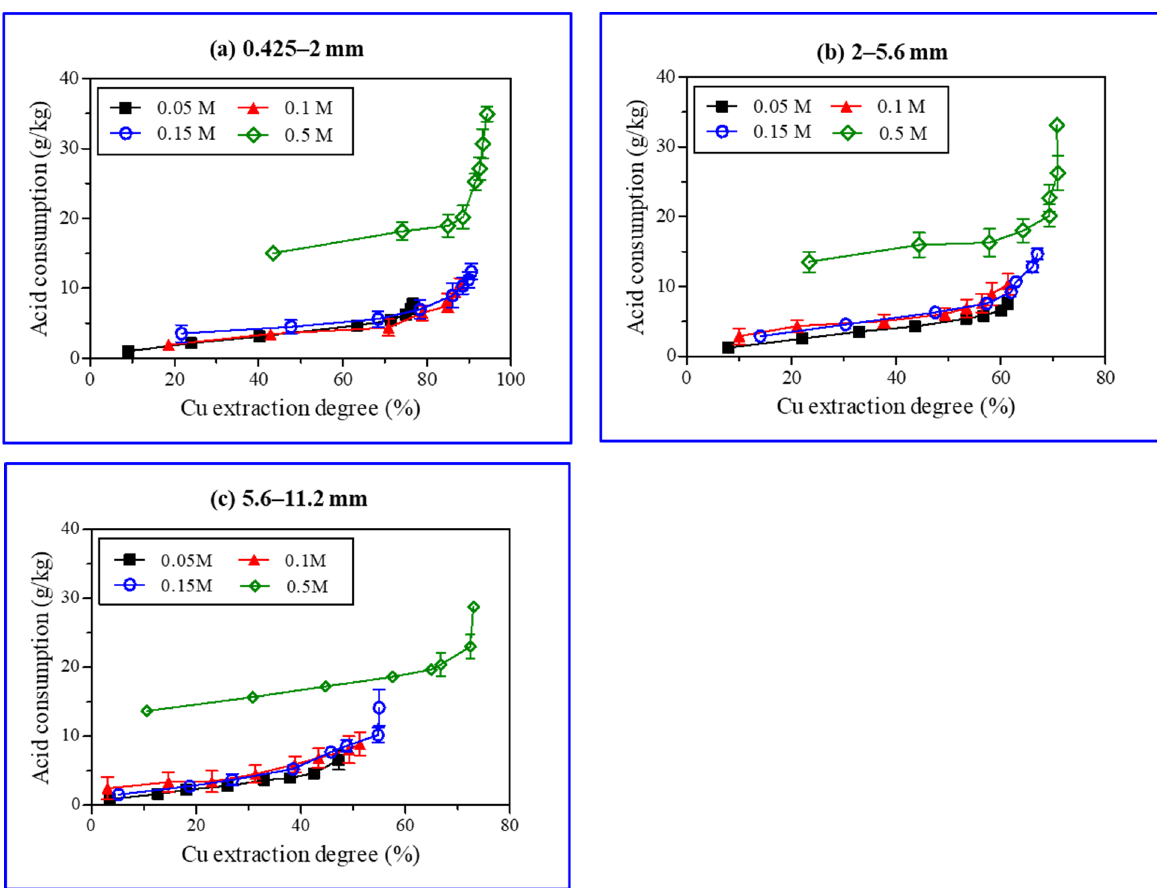
Figure 8. Sulfuric acid (H 2 SO 4 ) consumption (g/Kg) and copper extraction degree (%) during batch leaching experiments (0.425–2 mm ( a ), 2–5.6 mm ( b ), 5.6–11.2 mm ( c )).